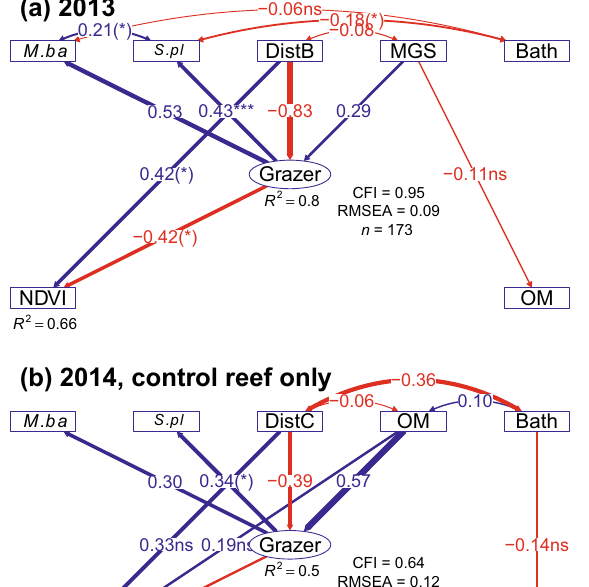
Fig. 3 Path diagrams showing the change in spatial patterns in MPB and other variables, from before to after the sacri fi ce of the treatment reef via burning. a and d show before (2013), models based on n = 173 and 92, respectively; b and c show after (2014), models based on n = 115 for each (see methods for details). b assumes the burning nulli fi ed the effect of the treatment reef (i.e., under hypothesis 1 or 3), while c assumes no post- burning change in the effect of the treatment reef (i.e., under hypothesis 2). Inset legend shows model fi t statistics. Paths between variable nodes and their edge width show the standardised correlation coef fi cients ( β ), the effect of a variable in isolation (other variables held constant). Paths weaker than β = ±0.05 are not displayed. Sample sizes and standard errors of endogenous variables were corrected for spatial autocorrelation and used to calculate signi fi cance levels, denoted by asterisks: * p < 0.05, ** p < 0.01, *** p < 0.001. One-headed arrows depict hypothesised causal relationships. Two-headed arrows depict residual covariance. The circular node shows the latent variable ‘ Grazer ’ , representing top-down effects of macrofaunal grazers. Square nodes denote directly measured variables, including organic matter ( ‘ OM ’ ), NDVI, sediment median grain size ( ‘ MGS ’ ), bathymetry ( ‘ Bath ’ ; roughly a y-trend), biomasses of M. balthica ( ‘ M.ba ’ ) and of S. plana ( ‘ S.pl ’ ), abundances of Nematoda ( ‘ Nem ’ ) and Copepoda ( ‘ Cop ’ ), and the square root of distance from the control reef (DistC) or from both reefs (DistB; highest values are nearest to the reefs). For clarity, residual variances are not